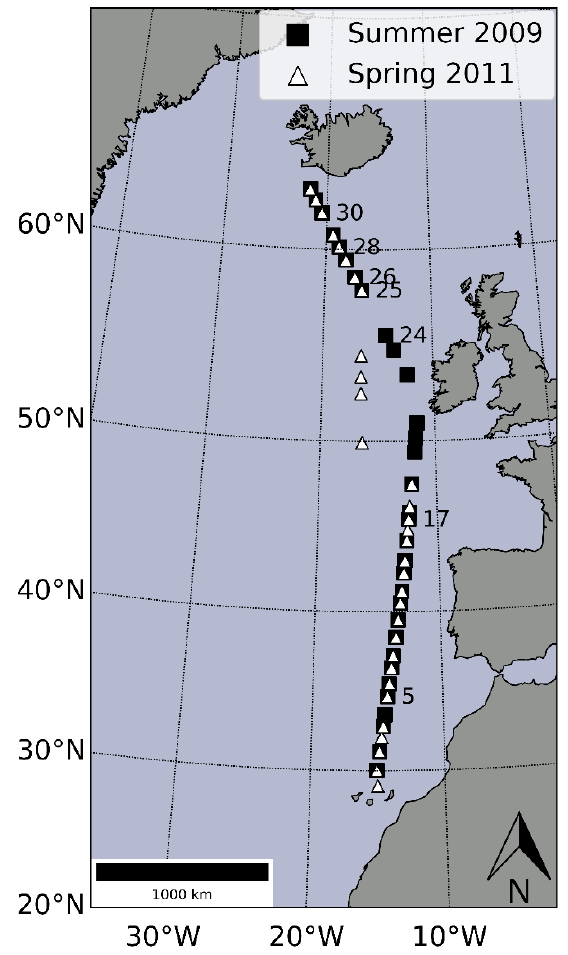
Figure 1. Northeast Atlantic Ocean with stations of the spring (April – May 2011, white triangles) and summer (July – August 2009, black squares) Stratiphyt cruises. summer (July–August 2009, black squares) Stratiphyt